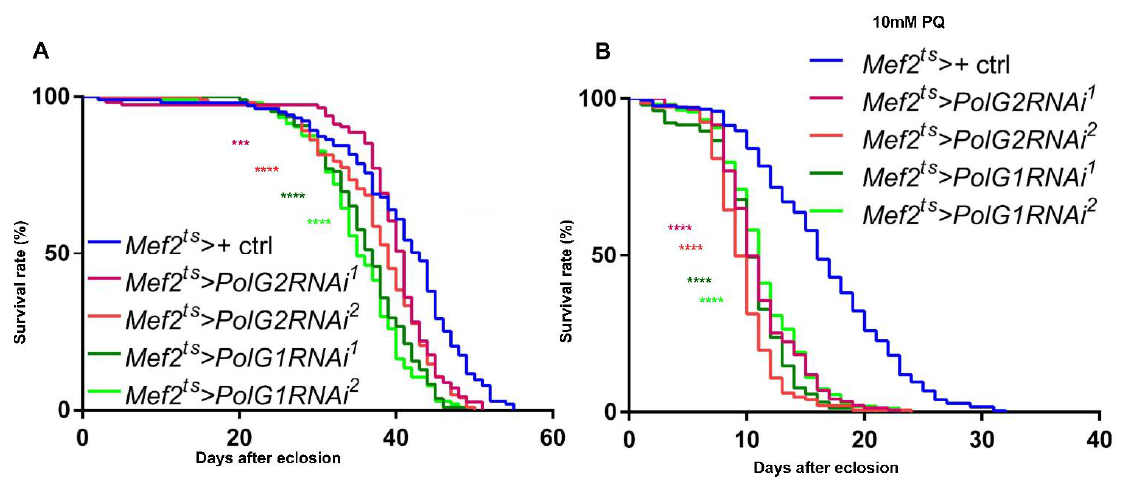
Figure 8. Lifespan curves of adults harboring muscle-specific PolG1RNAi and PolG2RNAi and survival curves of adults fed PQ. ( A , B ) Lifespan curves of control adults ( Mef2 ts > + ) and Pol γ RNAi adults ( Mef2 ts > PolG2RNAi 1 , Mef2 ts > PolG2RNAi 2 , Mef2 ts > PolG1RNAi 1 , and Mef2 ts > PolG1RNAi 2 ) fed on the instant fly food ( A ) or the food supplemented with 10 mM PQ ( B ). The flies collected within 1 day after eclosion were used for ( A ) ( n = 103 control adults, n = 114 Mef2 ts > PolG2RNAi 1 adults, n = 102 Mef2 ts > PolG2RNAi 2 , n = 109 Mef2 ts > PolG1RNAi 1 , and n = 104 Mef2 ts > PolG1RNAi 2 ) and used for ( B ) ( n = 177 control adults, n = 143 Mef2 ts > PolG2RNAi 1 adults, n = 147 Mef2 ts > PolG2RNAi 2 , n = 156 Mef2 ts > PolG1RNAi 1 , and n = 163 Mef2 ts > PolG1RNAi 2 ). More than 5 trials with the total number of adults described were performed in every assay type. The survival rate of the flies was examined every 24 h (*** p < 0.001, **** p < 0.0001, log-rank test).